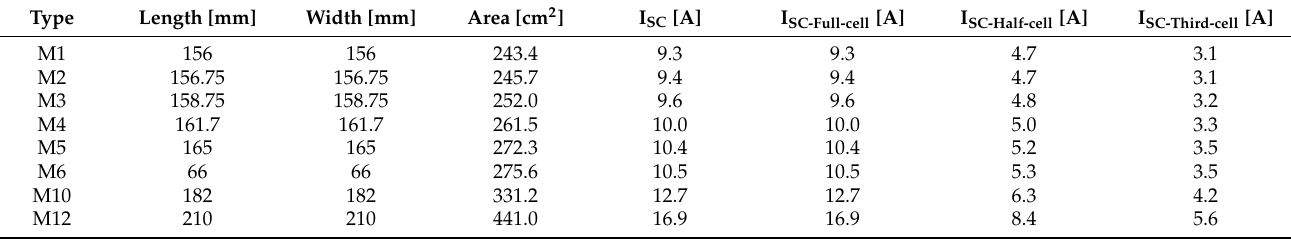
Table 1. Different wafer dimensions and their related short-circuit current for partial cells.